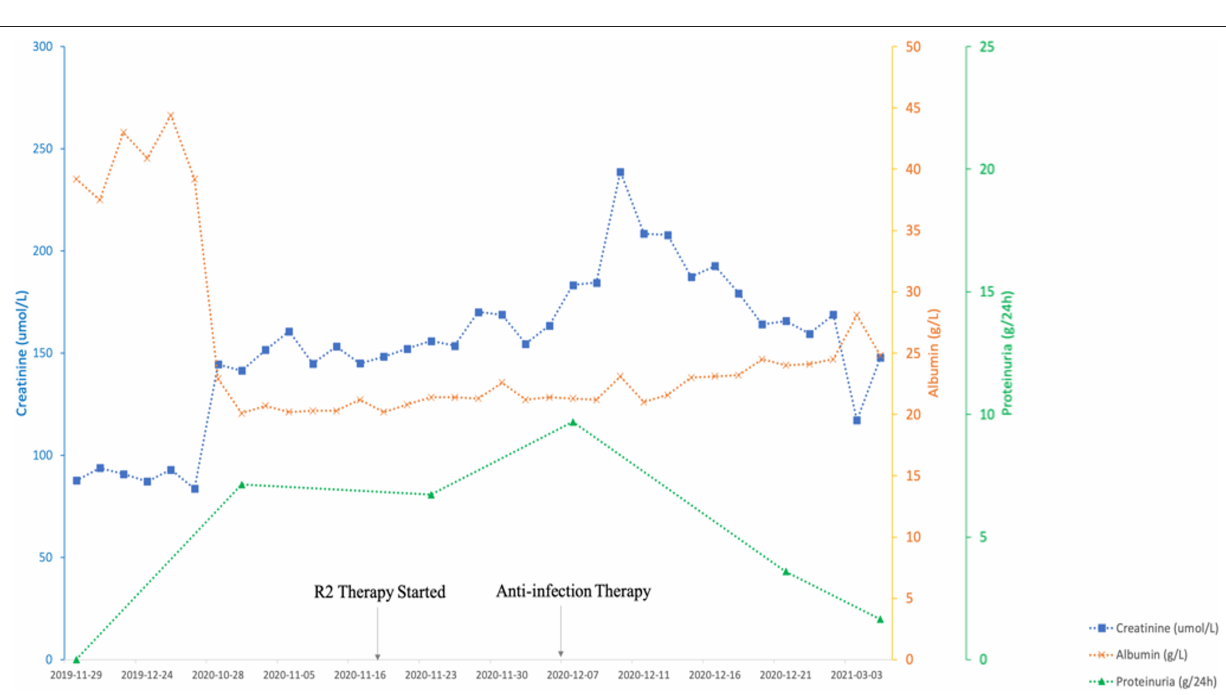
Frontiers in Medicine | www.frontiersin.org